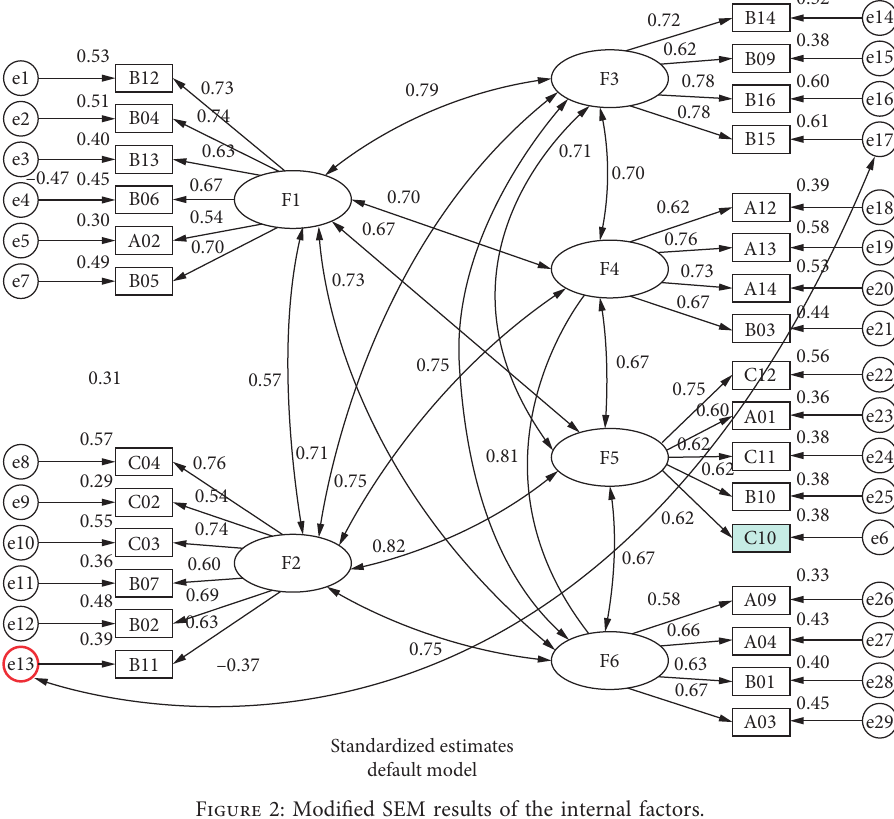
Figure 2: Modified SEM results of the internal factors.